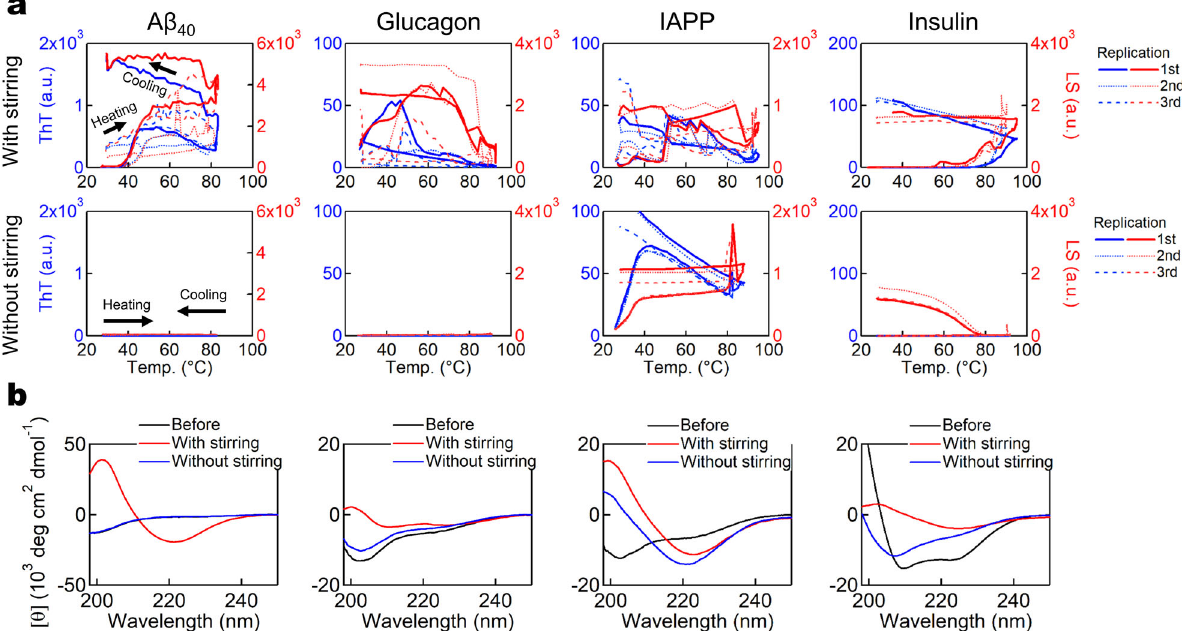
Fig. 3 Effects of heating and agitation on type A proteins. a ThT assays of A β 40 , glucagon, IAPP, and insulin upon heating in the presence (upper) or absence (lower) of stirring. n = 3. b CD spectra of each sample before and after the ThT